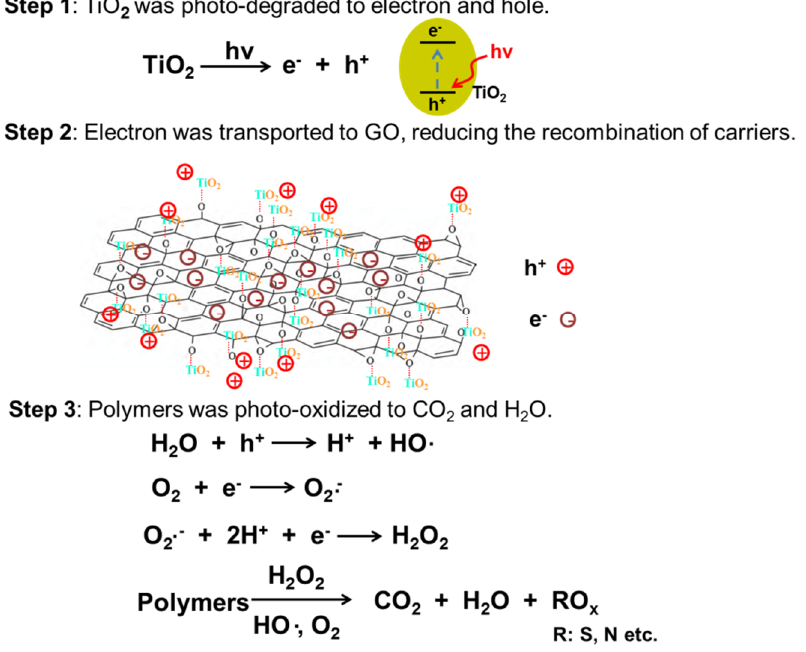
Scheme 3. Schematic representations for the proposed reaction from polymers to CO 2 , H 2 O, and RO X in natural environments.